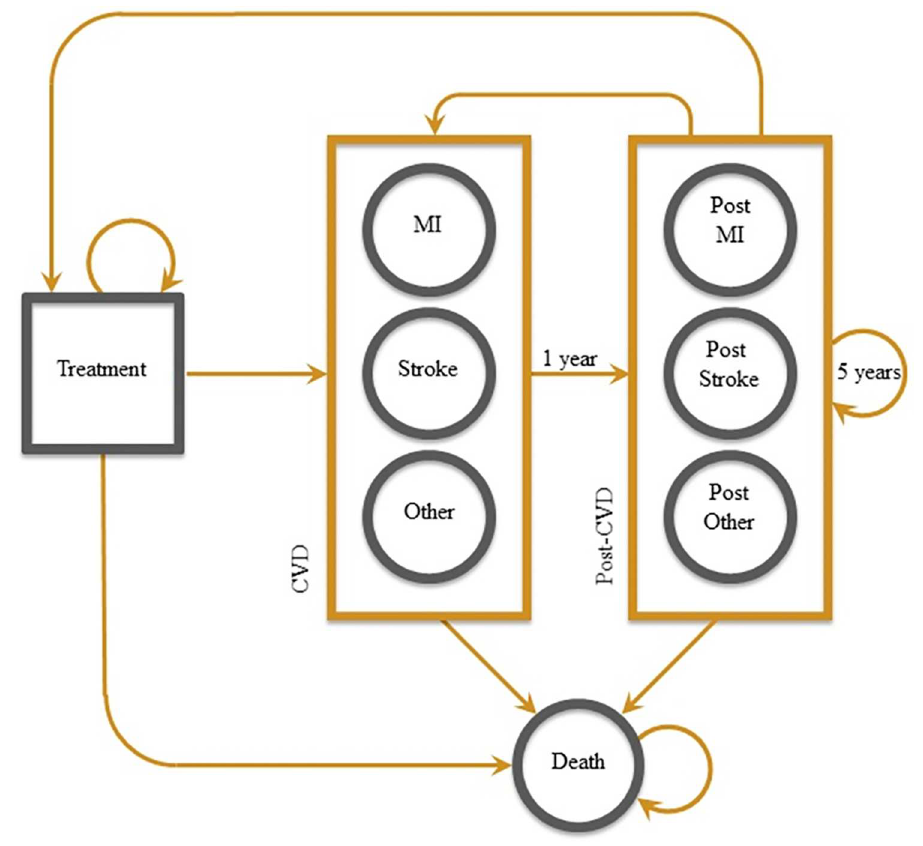
Fig 1. Decision-analytic model describing treatment and CVD events. Treatment could be PCSK9 inhibitoror standard-therapy. MI: MyocardialInfarction. Other: Other CVD event includingunstableangina, transient ischemic attack, congestiveheart failure,